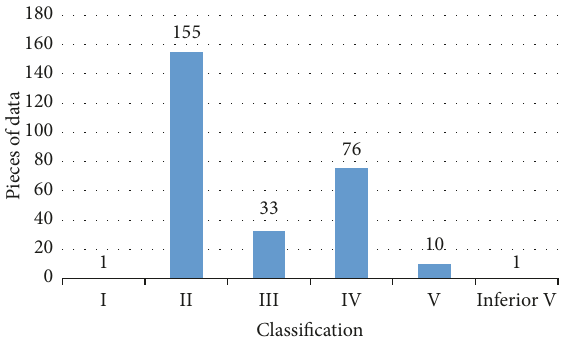
Figure 1: Classification distribution graph of